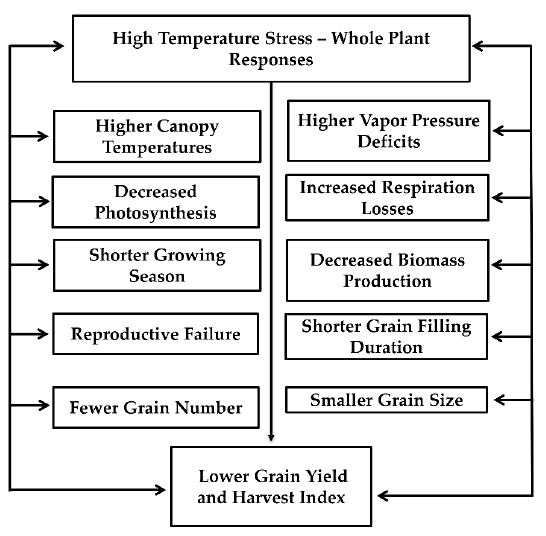
Figure 2. Effects of high temperature stress on physiological and yield processes in grain crops. In brief, when plants are exposed to high air temperatures it leads to higher vapor pressure deficit and increased canopy temperatures, increased respiration, and decreased photosynthesis, leading to decreased biomass production. Higher temperatures shorten the growing season and shorten the grain filling duration, resulting in smaller grain size. Similarly, higher temperature causes reproductive failure leading to lower grain numbers. Fewer grain number and smaller grain size results in lower grain yield and harvest